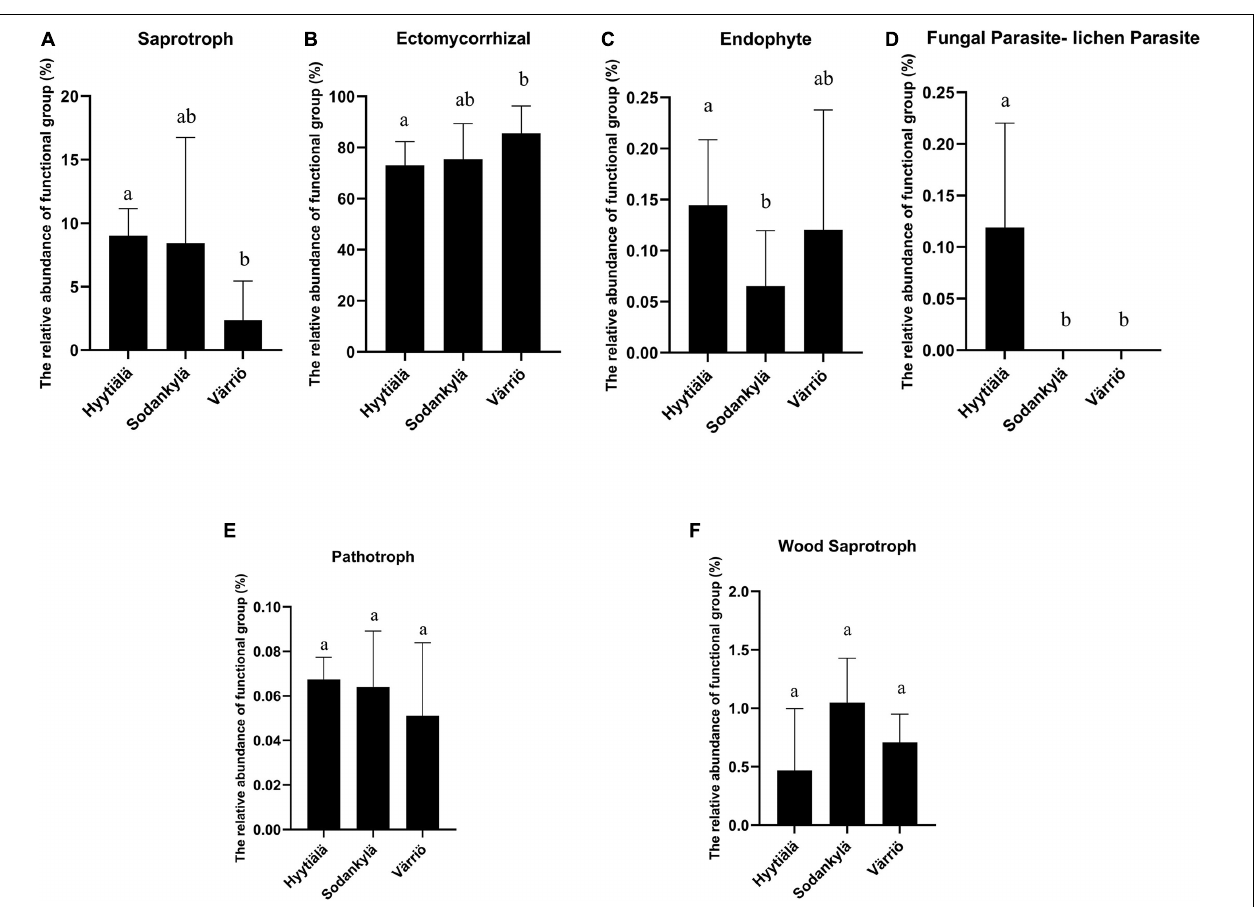
FIGURE 5 | The functional groups showing significant differences (A–D) and commonly presented (E,F) in the three locations between Hyytiälä (southern), Sodankylä (northern) and Värriö (subarctic) boreal pine forests. (A) saprotroph, (B) ectomycorrhizal, (C) endophyte, (D) fungal parasite-lichen parasite s, (E) pathotroph, and (F) wood